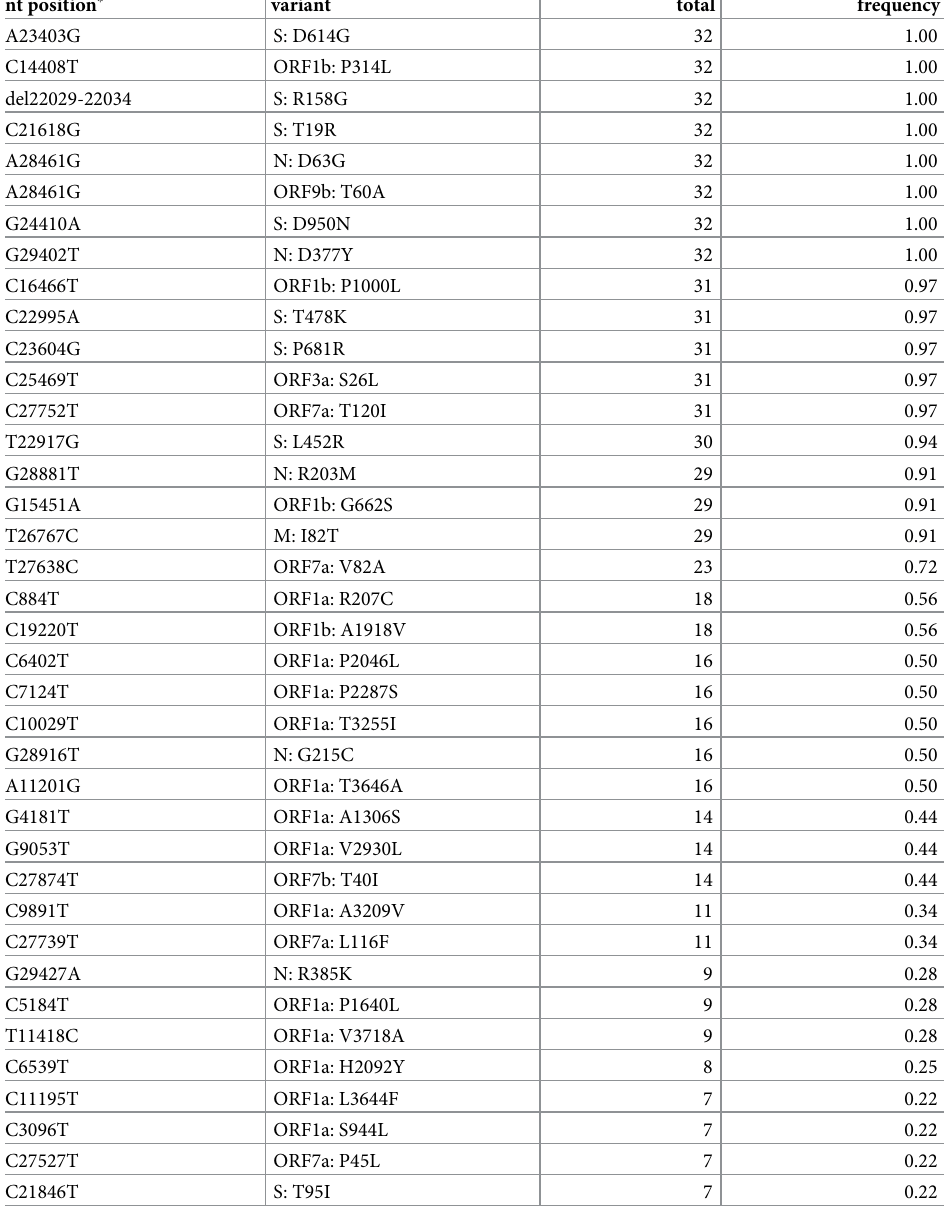
According to the Nexststrain phylogenetic grouping based on the amino acid and several nucleotide substitutions, the Delta isolates from our study were divided into the two main sub- clades 21A (n = 18; 56.2%) and 21J (n = 14; 43.8 (Figs 6 and 7). All isolates in the subclade 21J were mainly defined by a frequently observed synonymous nucleotide substitution C8986T, and the amino acid substitutions at the ORF1a: A1306S (G4181T), P2046L (C6402T), P2287S (C7124T), V2930L (G9053T), T3255I (C10029T), T3646A (A11201G), ORF1b: A1918V